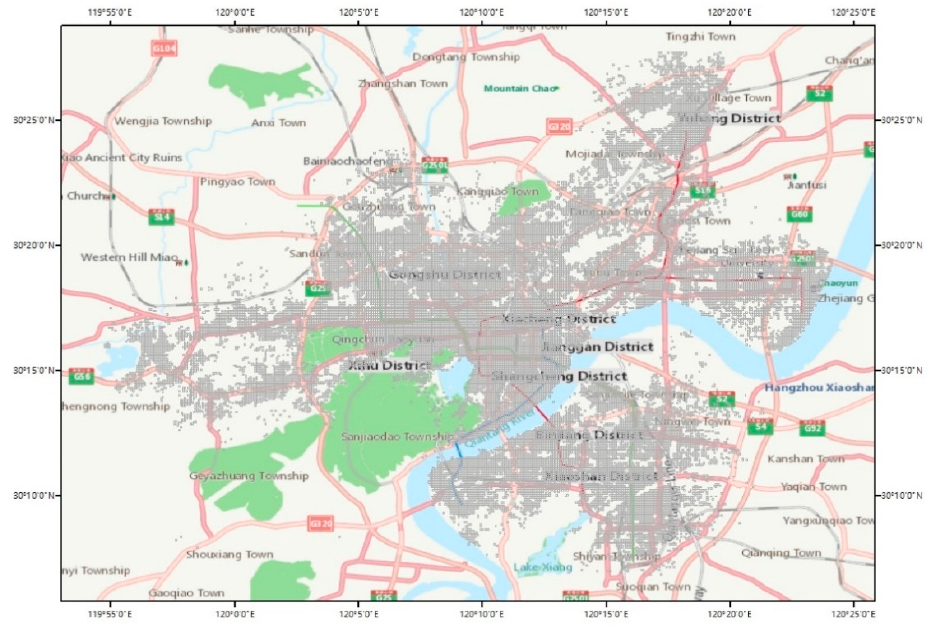
Figure 5. The research area covered by equal grids.